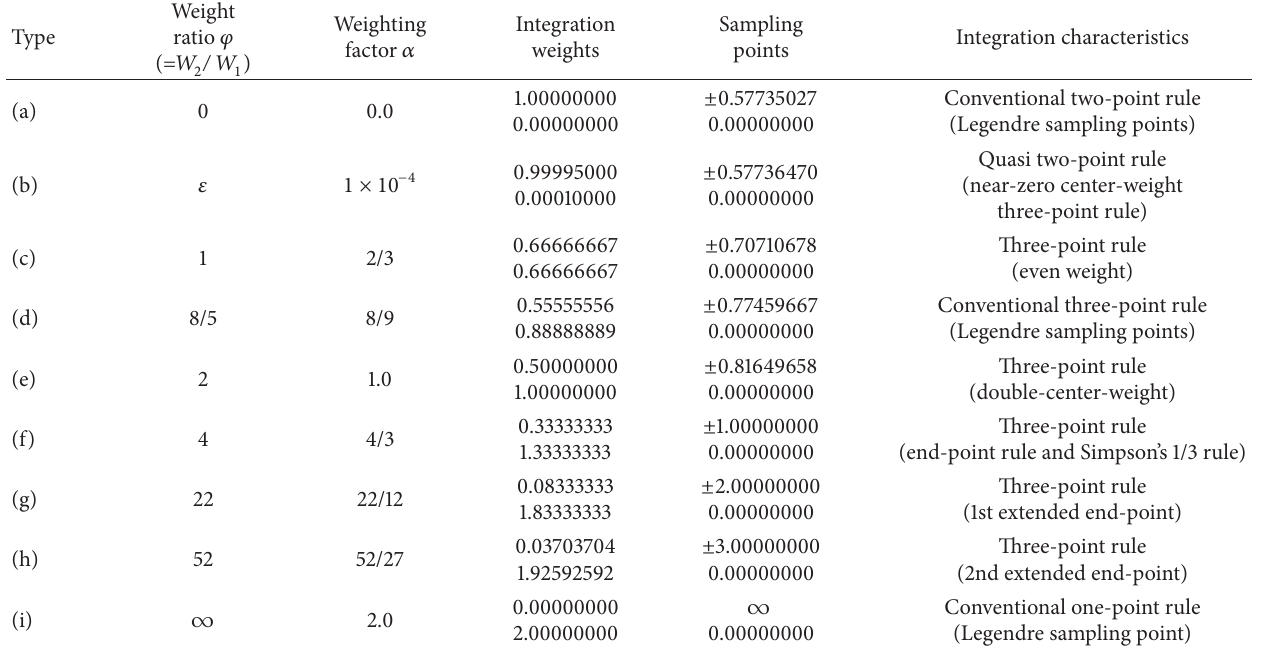
Table 1: Different types of 3-point Gauss integration of variable sampling points and the integration